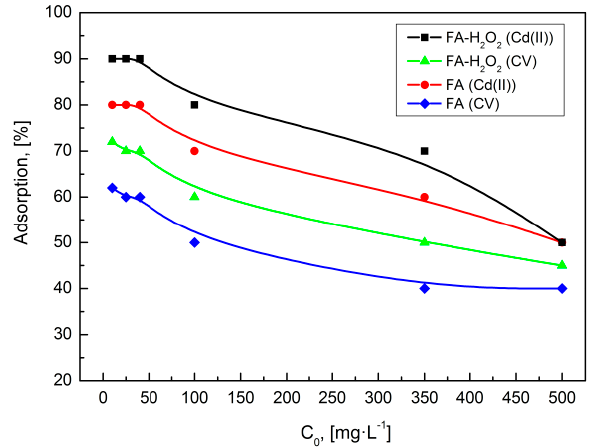
Figure 8. Effect of initial Cd(II) ion and CV concentration on the adsorption of FA and FA–H 2 O 2 .